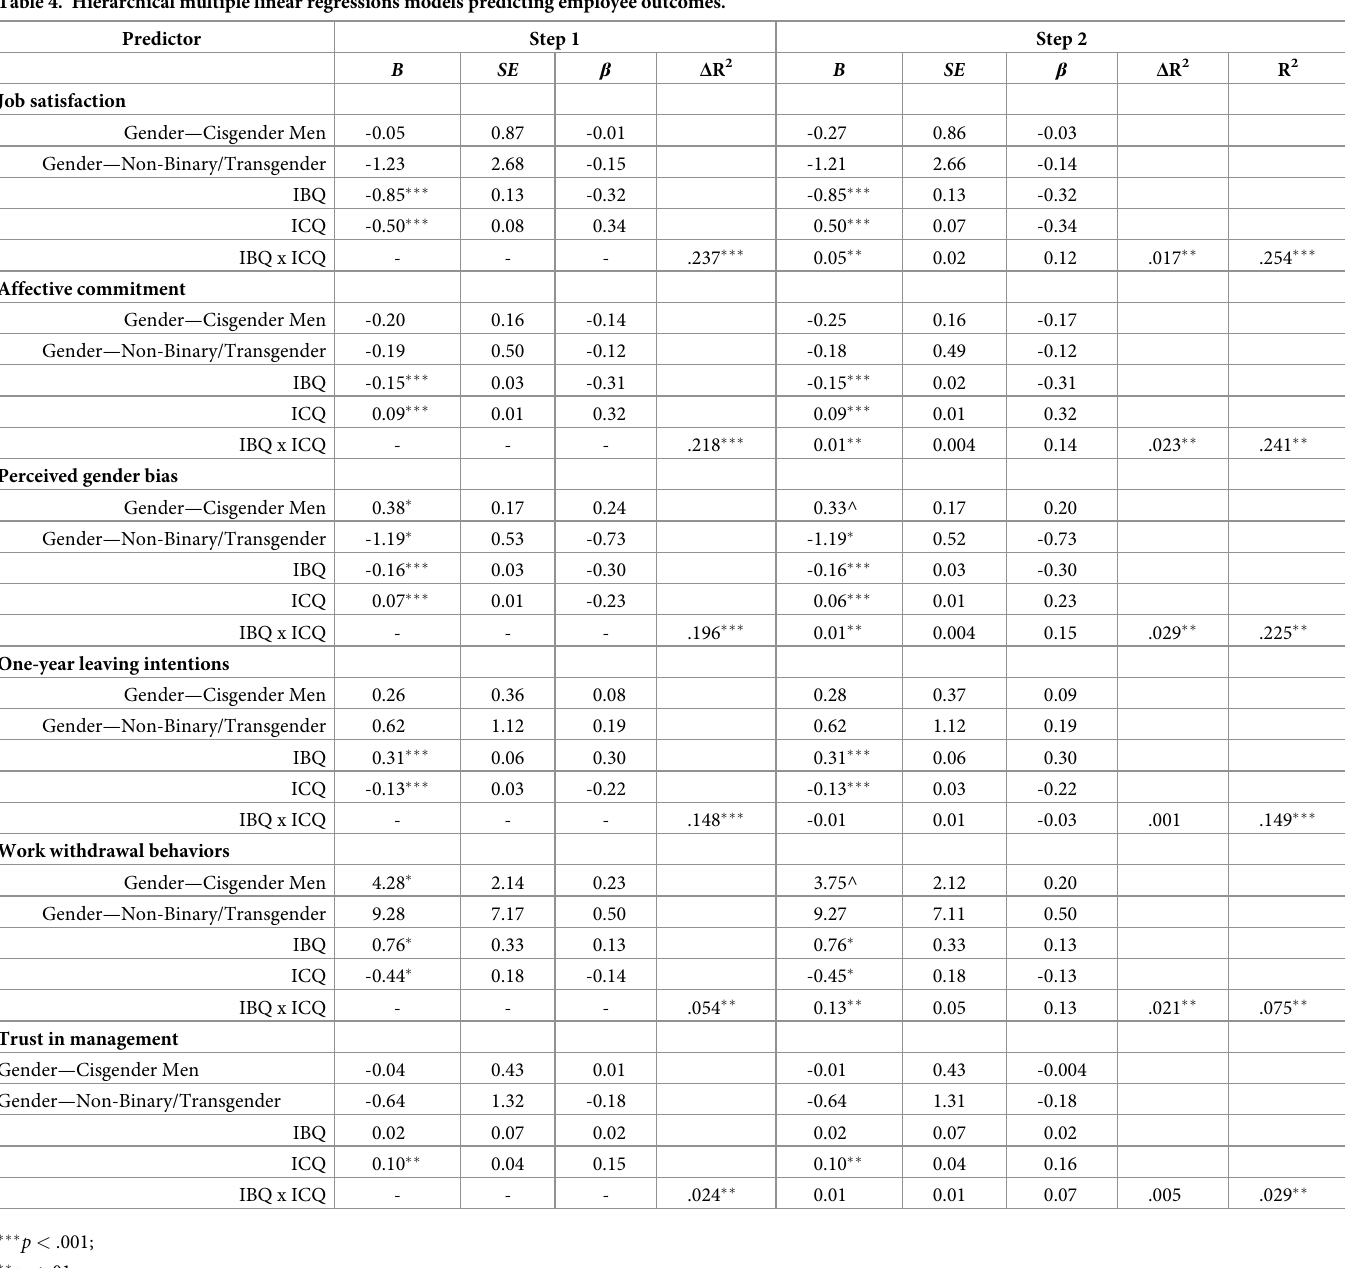
Table 4. Hierarchical multiple linear regressions models predicting employee outcomes.